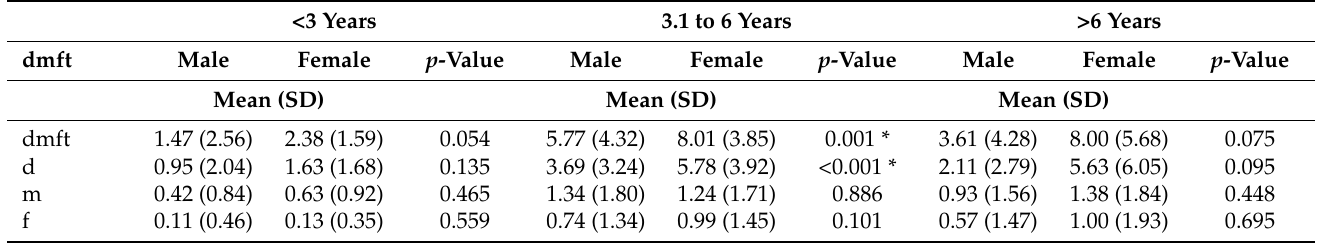
The gender comparison among the age groups should have mixed results. The dmft scores in the 3.1–6 years of age group showed statistical significance ( p < 0.001), while gender comparison among <3 years and >6 years should be statistically non-significant studied. The gender-based comparison among the various age groups is summarized in Table 3. Table 3. Comparison of dmft based on gender in different age